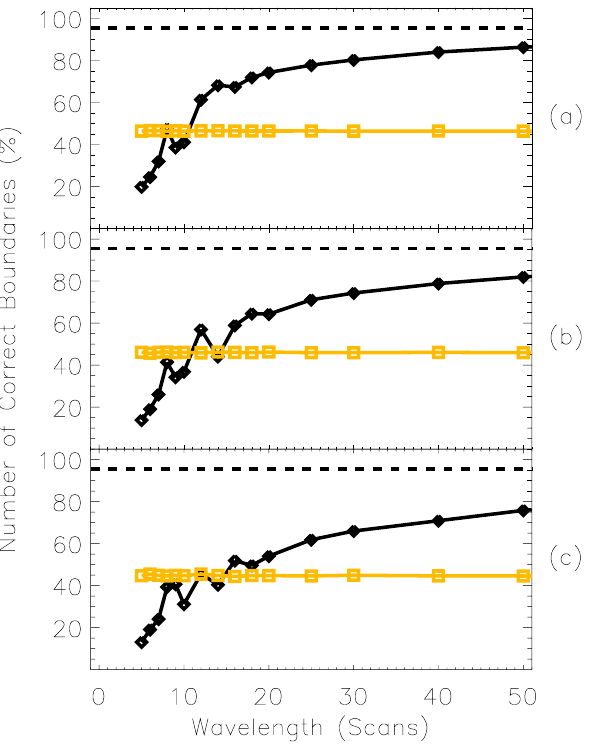
Fig. 12. The variation in the rms boundary error measured by algo- rithm 2 (solid orange line) and algorithm 3 (solid black line), with a threshold of 150 m/s, when applied to a simulated data set with a variable sinusoidal boundary. The variations are presented for a range of boundary wavelengths and for sinusoidal amplitudes of (a) 2, (b) 3, and (c) 4 range gates. The black dashed line presents the value measured by algorithm 3 when no boundary variation is present (as in Fig.